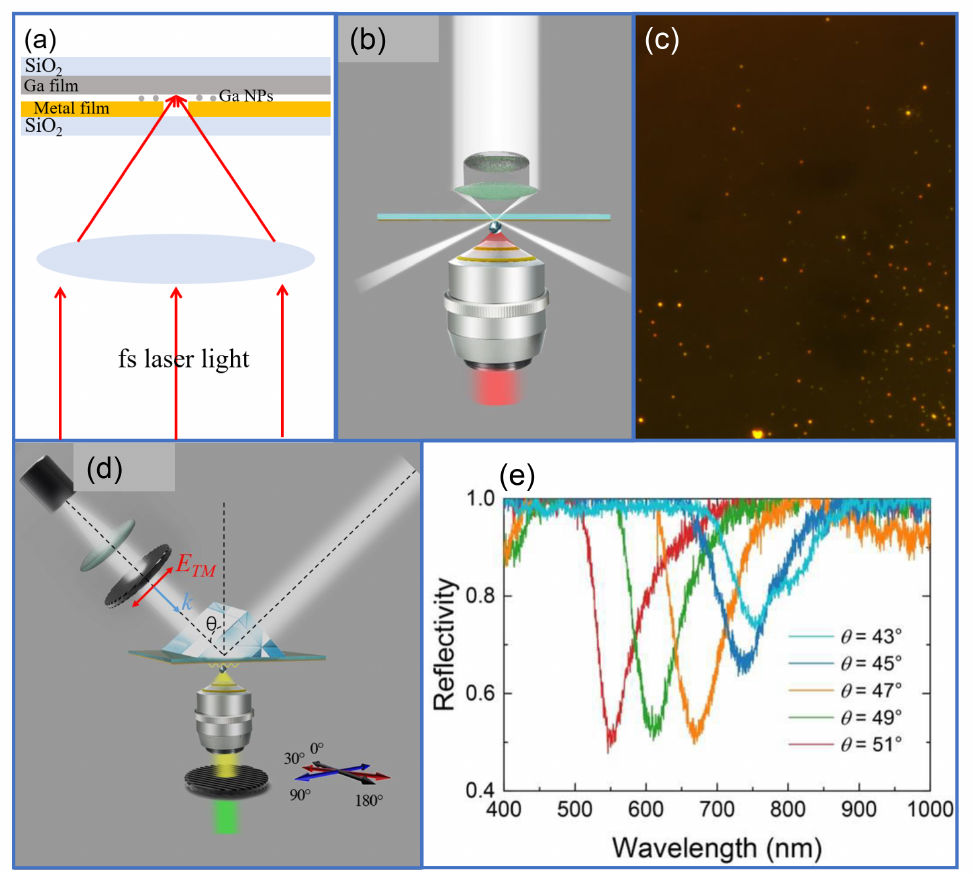
Figure 1. ( a ) Schematic showing the fabrication of Ga nanoparticles (NPs) on a metal/SiO 2 substrate by using fs laser ablation of a Ga film. ( b ) Schematic illustrating the measurement of the forward scattering spectrum of a Ga NP coupled to a metal film in a conventional dark-field microscopy. ( c ) Optical image of Ga NPs coupled to an Ag film. ( d ) Schematic illustrating the excitation of a Ga NP coupled to a thin metal by using the surface plasmon polaritons (SPPs) generated on the metal surface via the Kretschmann-Raether (K-R) configuration, and the detection of scattering signal with a polarization analyzer. ( e ) Spectra of the reflected light from the Au film with increasing incidence angle measured in the K-R